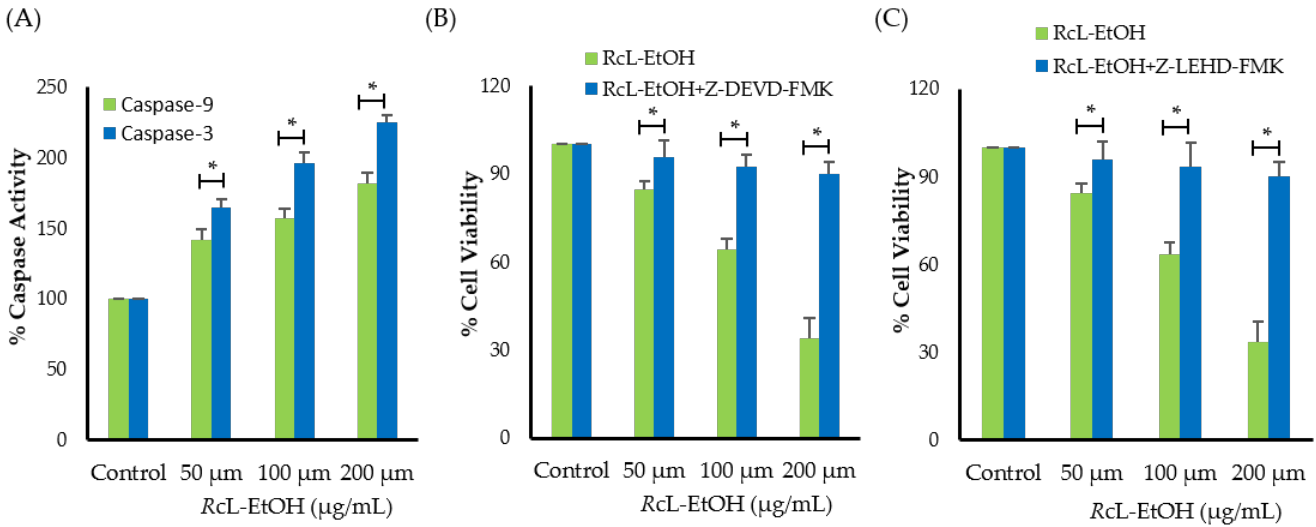
Figure 4. ( A ) Impact of R cL-EtOH on caspase-3 and -9 activities. Cell viability of A549 cells pre-treated with inhibitors of ( B ) caspase-3 and ( C ) caspase-9. * p < 0.05.